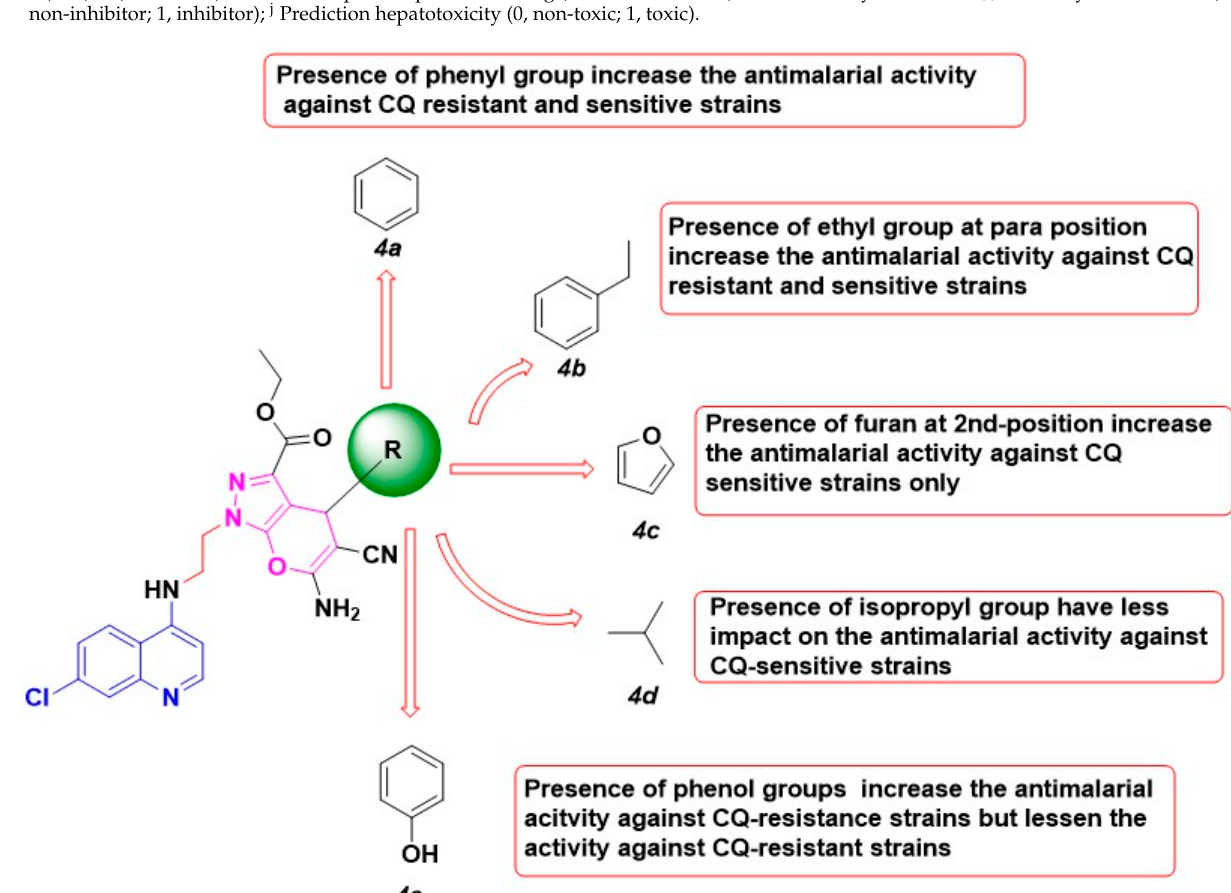
Figure 6. The structure ‐ activity relationship of synthesized compounds, 4a – e .